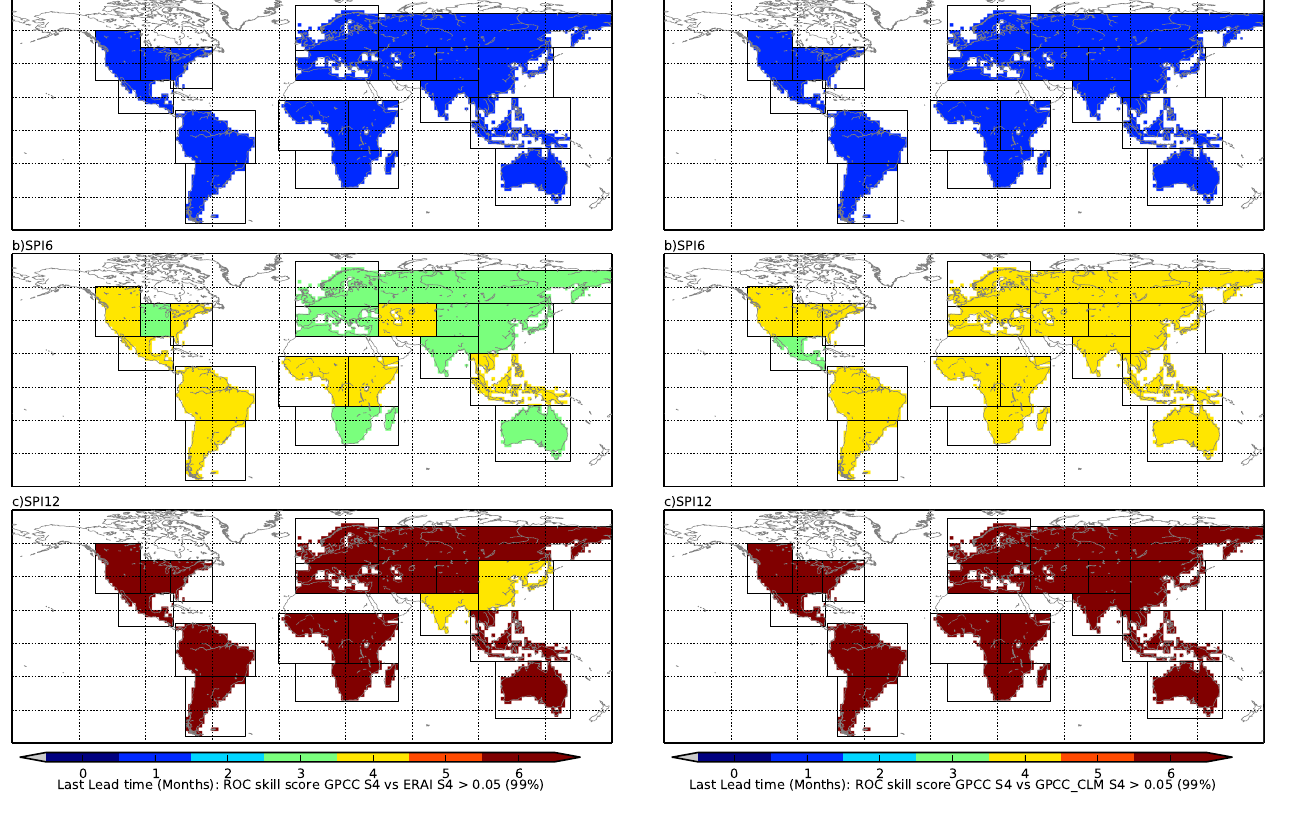
Figure 3. As Fig. 2 but using GPCC_CLM S4 as reference fore-